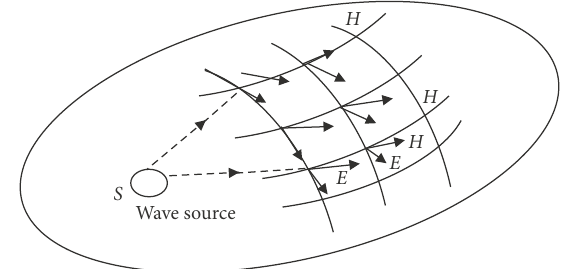
Figure 9: Wireless signal propagation diagram of the Huygens– Fresnel principle.